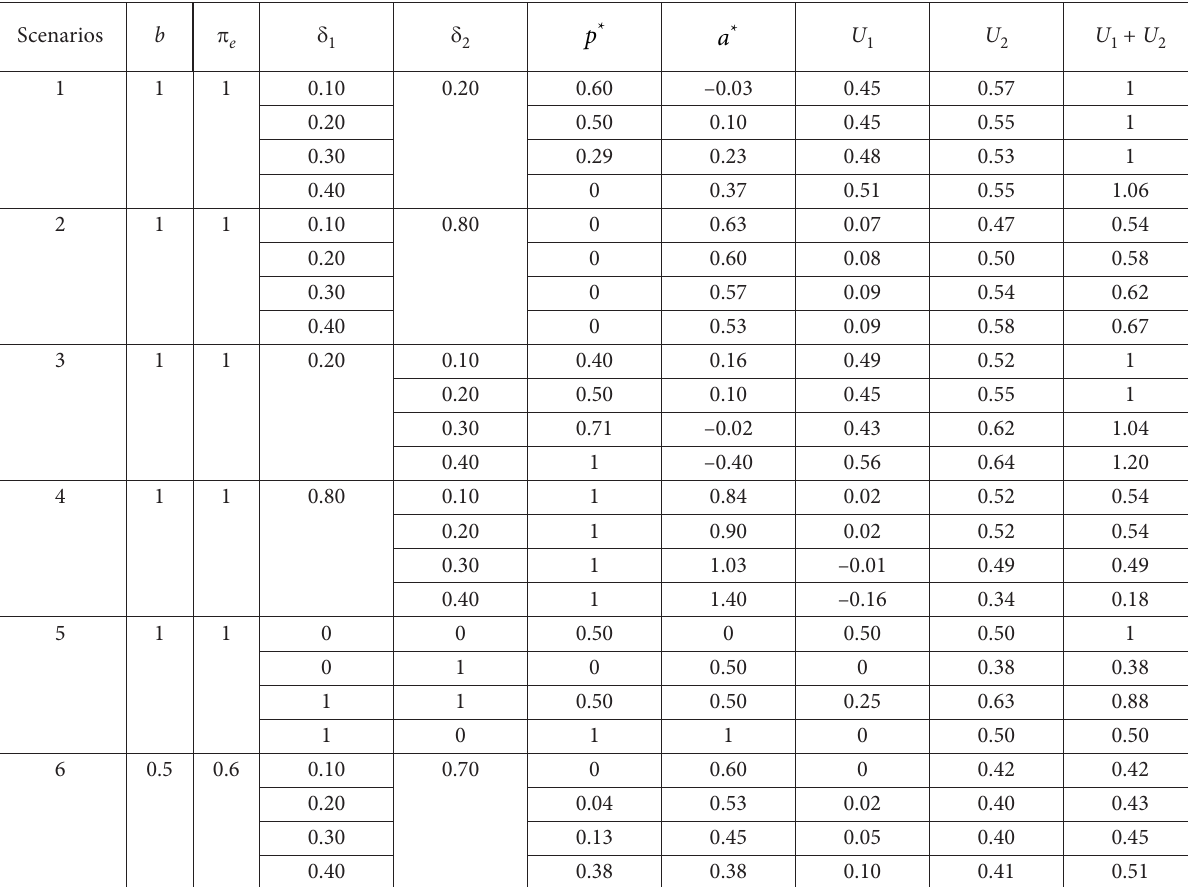
Table 2. Numerical